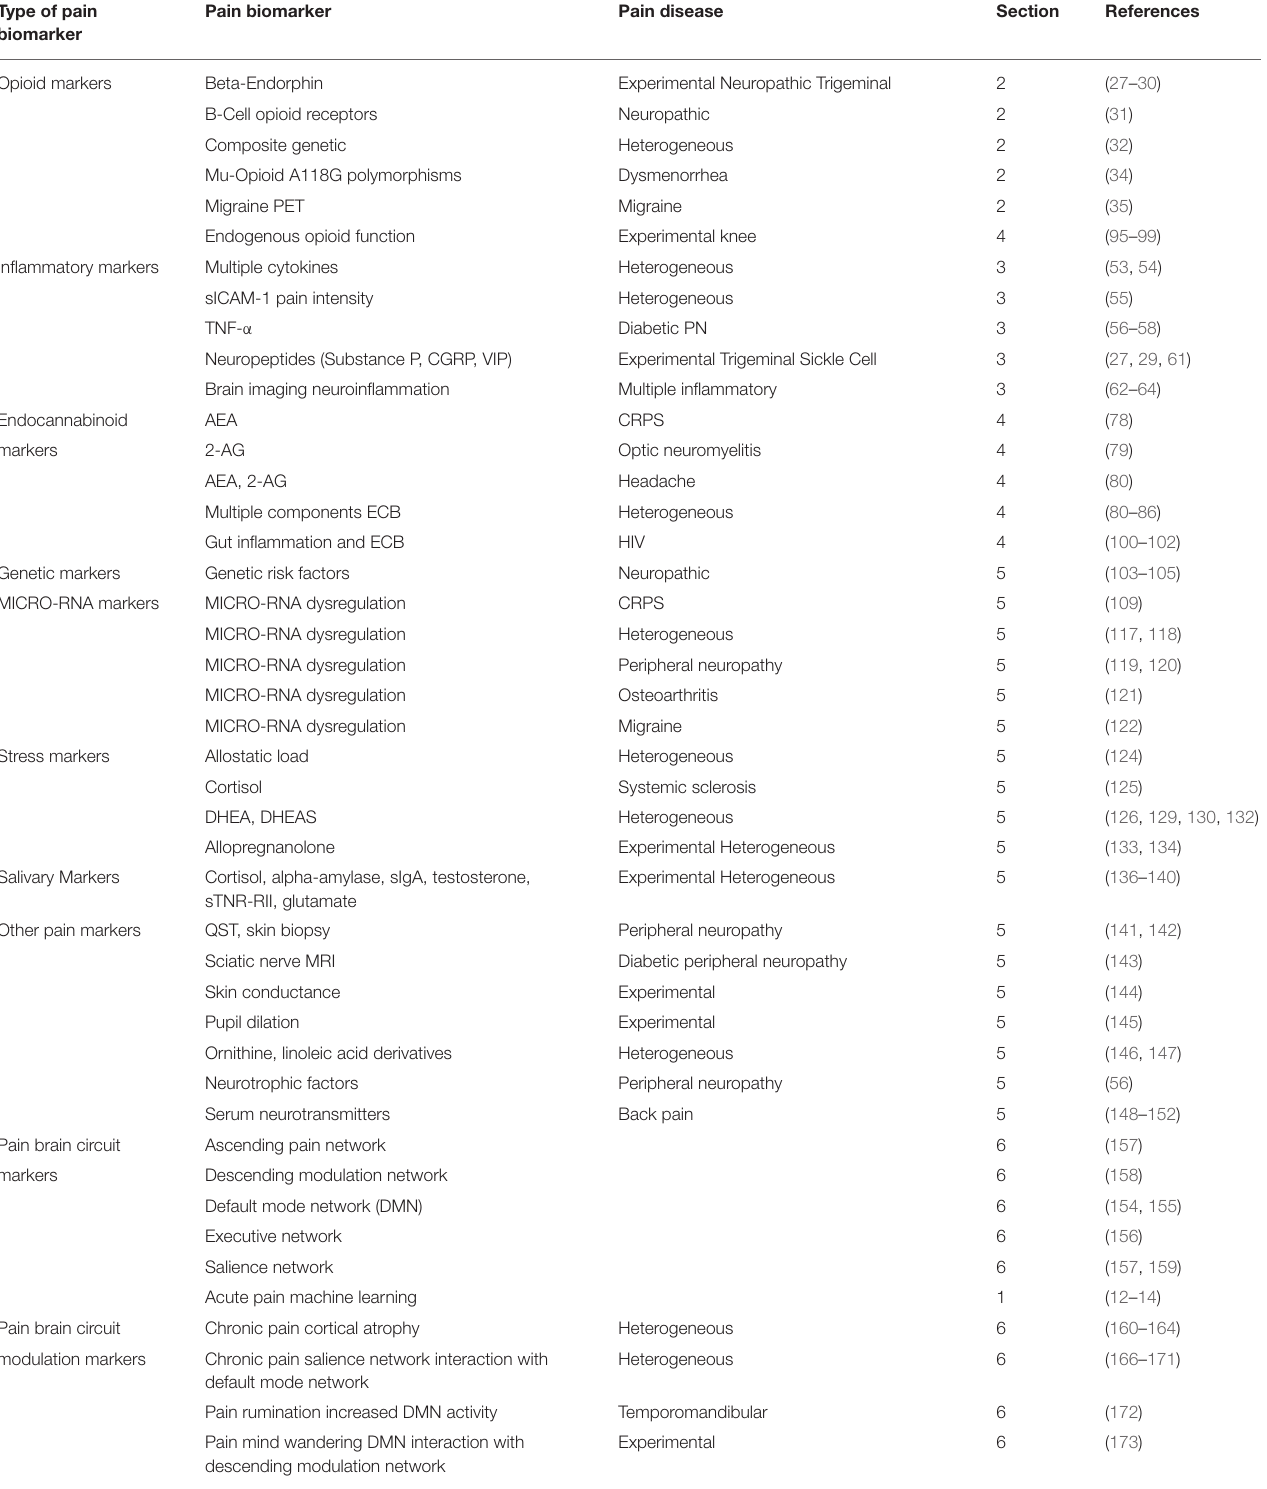
TABLE 1 | Summary table for pain